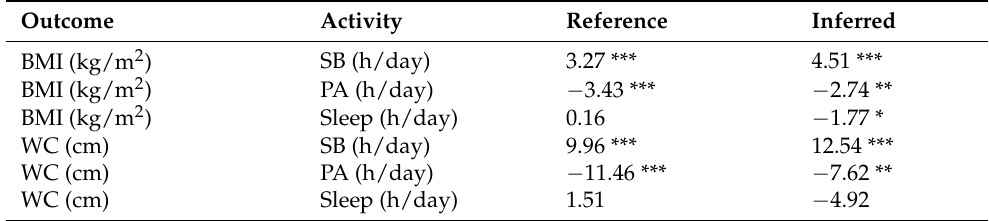
Figure 3. Bland–Altman plots for method agreement. The methods compared are the classification of activity by Willetts et al. [7] and by the HSMM. PA denotes the overall physical activity, as calculated by summing the time spent in moderate activity, walking and light tasks. Table 7. Linear regression coefficients for the associations between overall physical activity (PA), sedentary behaviour (SB) and sleep (Sleep) with anthropometric measures: BMI (body mass index) and WC (waist circumference). The coefficients represent the increase in outcome for each extra hour/day spend in each activity. The time spent in PA is calculated as the sum of time in moderate activity, walking and light tasks. The reference coefficients were estimated by using the labelled data by Willetts et al. [7], while the inferred coefficients were estimated by using our HSMM approach. (*: p -value < 0.05, **: p -value < 0.01, ***: p -value <